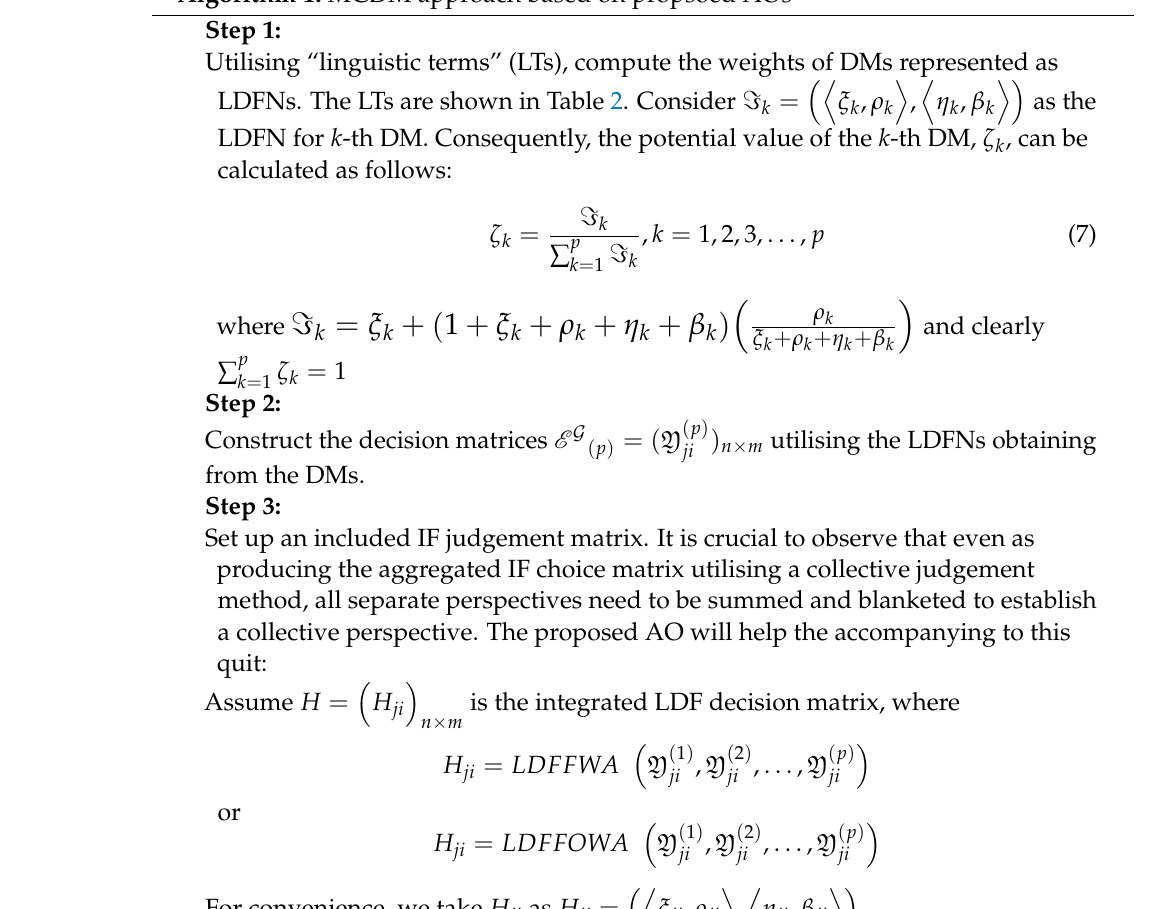
Algorithm 1: MCDM approach based on propsoed